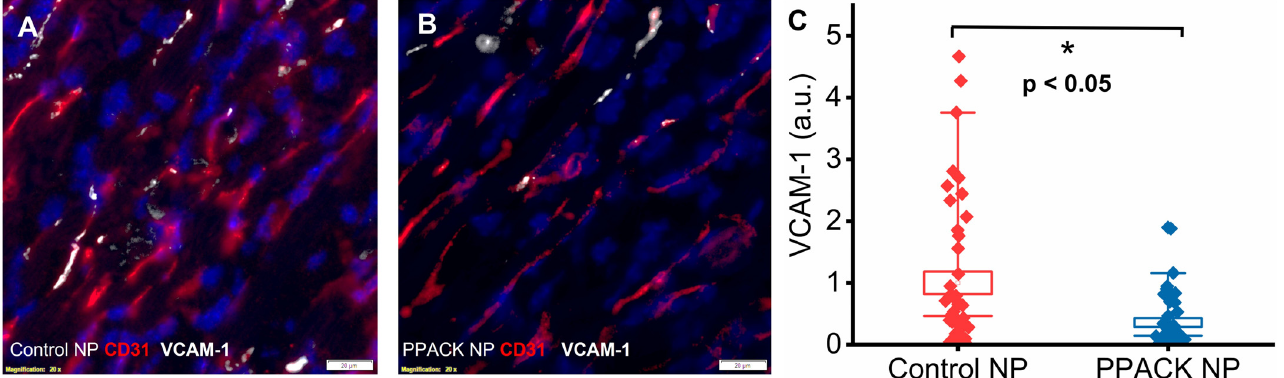
Figure 5. PPACK PFC NP treatment suppresses endothelial activation. ( A ) Immunofluorescent image of dual VCAM-1 (white) and CD31 (red) staining in heart section from control NP treated mouse. ( B ) Immunofluorescent image of VCAM-1 (white) and CD31 (red) staining in heart section from the PPACK NP treated mouse. DAPI was used for nuclei staining (blue). The size of the scale bar was 20 µm, and the magnification was 20×. ( C ) Quantification of VCAM-1 in the border zone regions of mice treated with either control NP or PPACK NP ( n = 3 mice per group; n = 42 PPACK NP, and n = 44 control NP regions of interest. Mean ± SEM; nonparametric analysis on n = 3; *: p < 0.05).